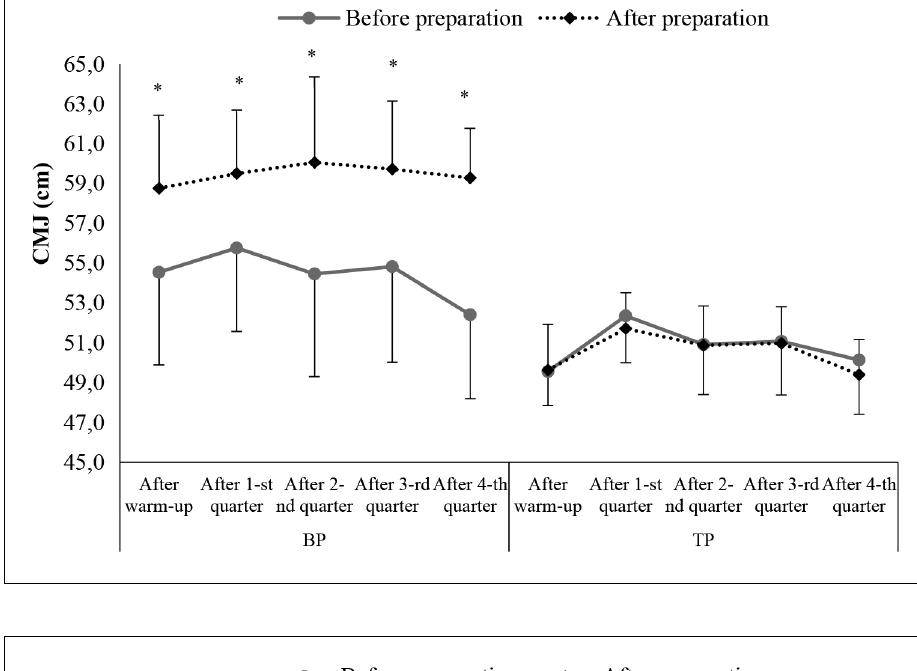
values of 20 meter sprint during the simulated basketball